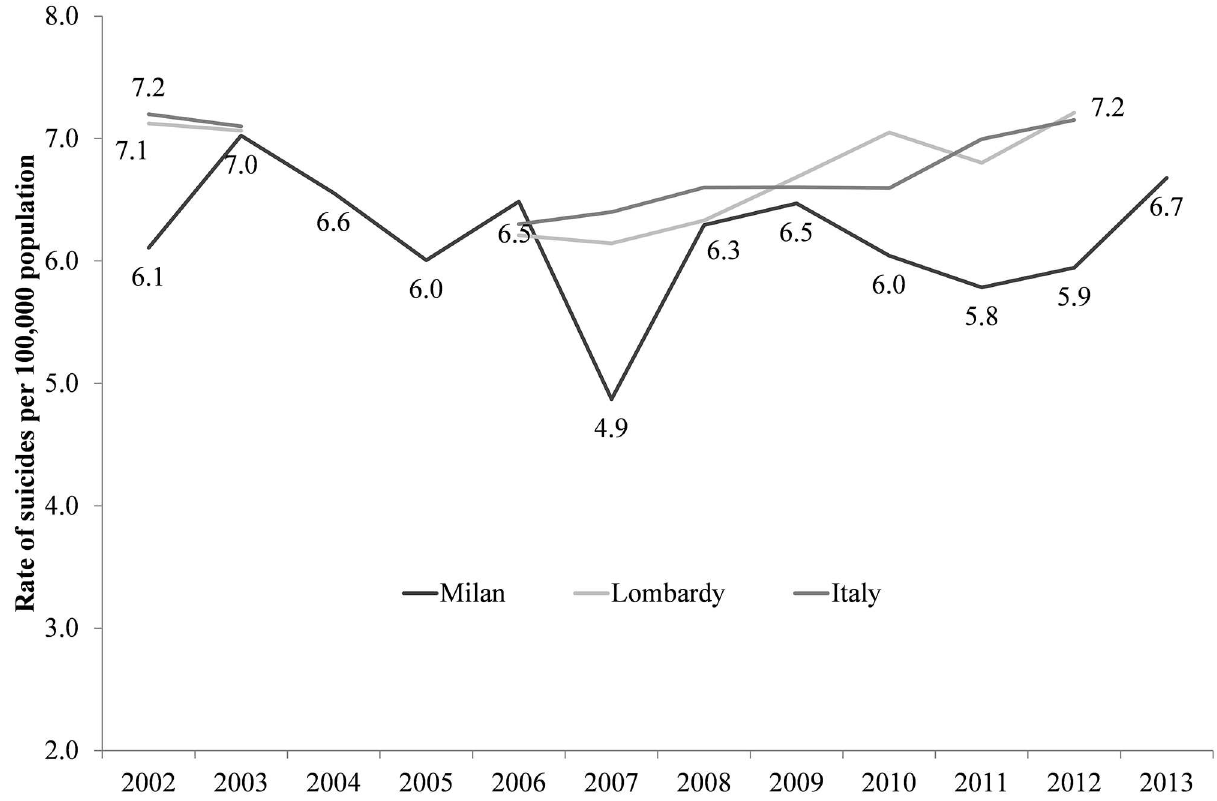
Fig 2. Number of suicides per 100,000population in the province of Milan, the Lombardy region and Italy (2002–2013). Source: Authors, basedon data from the Institute of Forensic Medicine,Milan and Istat.